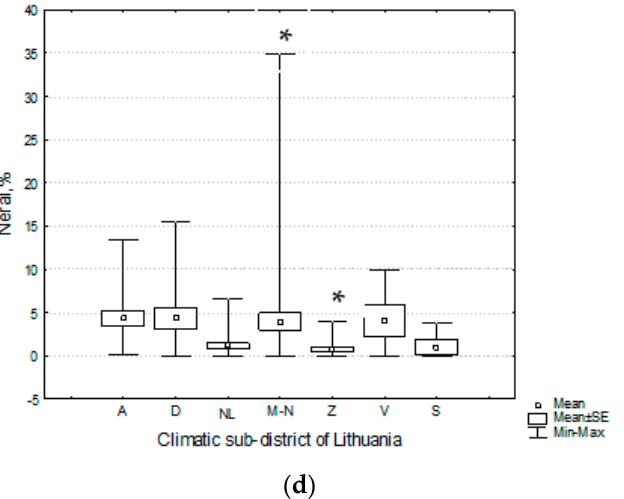
Figure 6. Distribution of the amount of geraniol ( a ), geranial ( b ), nerol ( c ), neral ( d ) in the essential oils of Thymus pulegioides habitats in different climatic sub-districts of Lithuania. Explication: A— Aukštaitija climatic sub-district, D—Dz ū kija, M-N—M ū ša Nev ė žis, NL—the Nemunas Lowland, S—S ū duva, V—Venta, Z—Žemai č iai. * denote statistically significant ( p < 0.05) differences. ** denote statistically significant ( p < 0.05) differences between habitats of Aukštaitija and the Nemunas Low- land climatic sub-districts by amount of nerol.